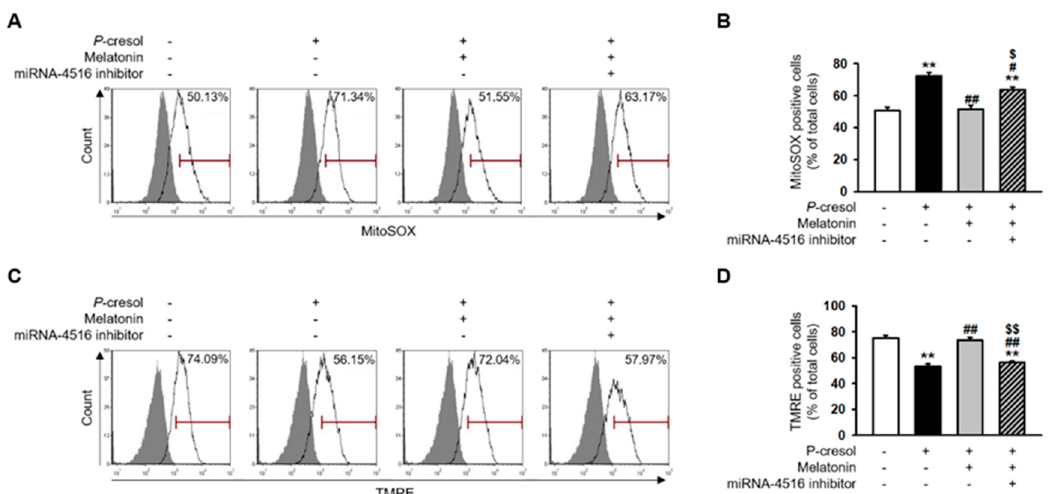
Figure 4. Melatonin inhibits mitochondrial ROS generation and restores mitochondrial membrane potential via increased expression of miR-4516. ( A ) Flow cytometry analysis of MitoSOX in melatonin-treated TH1 cells (1 µ M for 24 h) or cells pre-treated with the miR-4516 inhibitor (200 nM for 48 h) under P -cresol exposure (0.5 mM for 72 h) ( n = 3). ( B ) Quantification of the number of MitoSOX-positive cells. ( C ) Flow cytometry analysis of TMRE in melatonin-treated TH1 cells (1 µ M for 24 h) or cells pre-treated with the miR-4516 inhibitor (200 nM for 48 h) under P -cresol exposure (0.5 mM for 72 h) ( n = 3). ( D ) Quantification of the number of TMRE-positive cells. The values represent mean ± SEM. ** p < 0.01 vs. control, # p < 0.05,